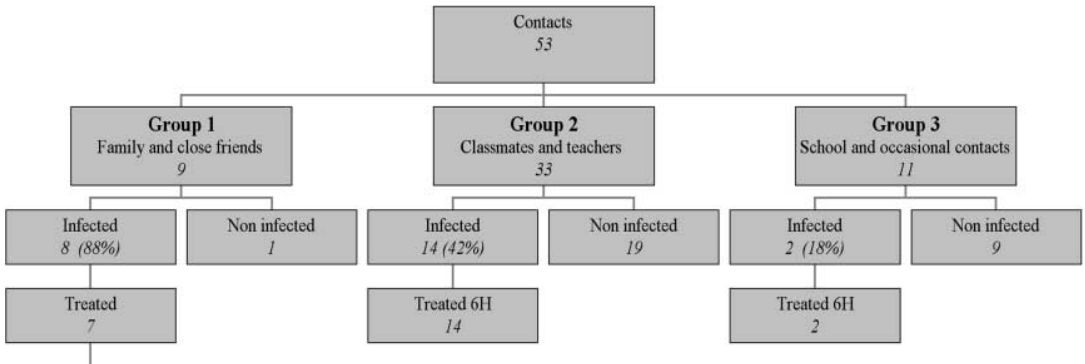
Figure 1 Global results of contact tracing by proximity